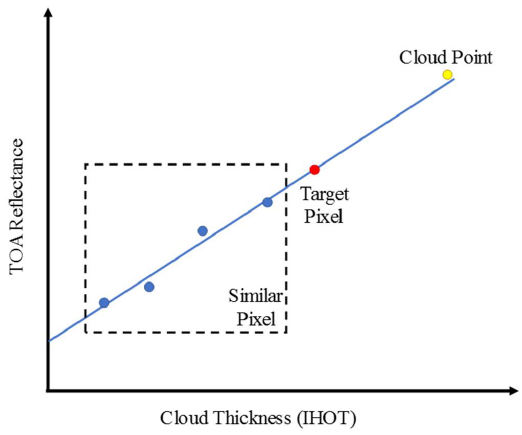
Figure 3. Illustration for the cloud trajectory fitting.